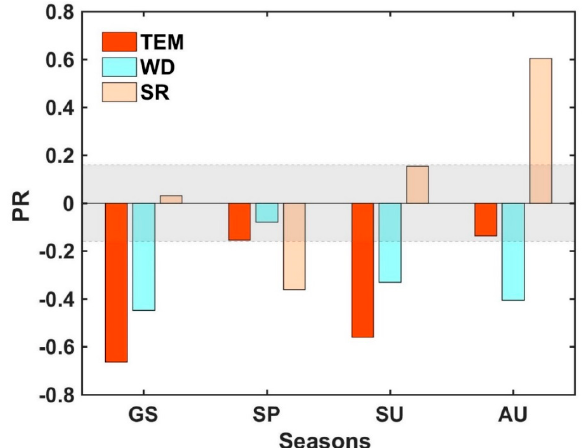
Figure 9. The partial correlation coefficient (PR) between the CV of seasonal mean NDVI and the CV of temperature (TEM), water deficit index (WD) and net solar radiation (SR) in our study region. GS, SP, SU and AU are growing season, spring, summer and autumn, respectively.